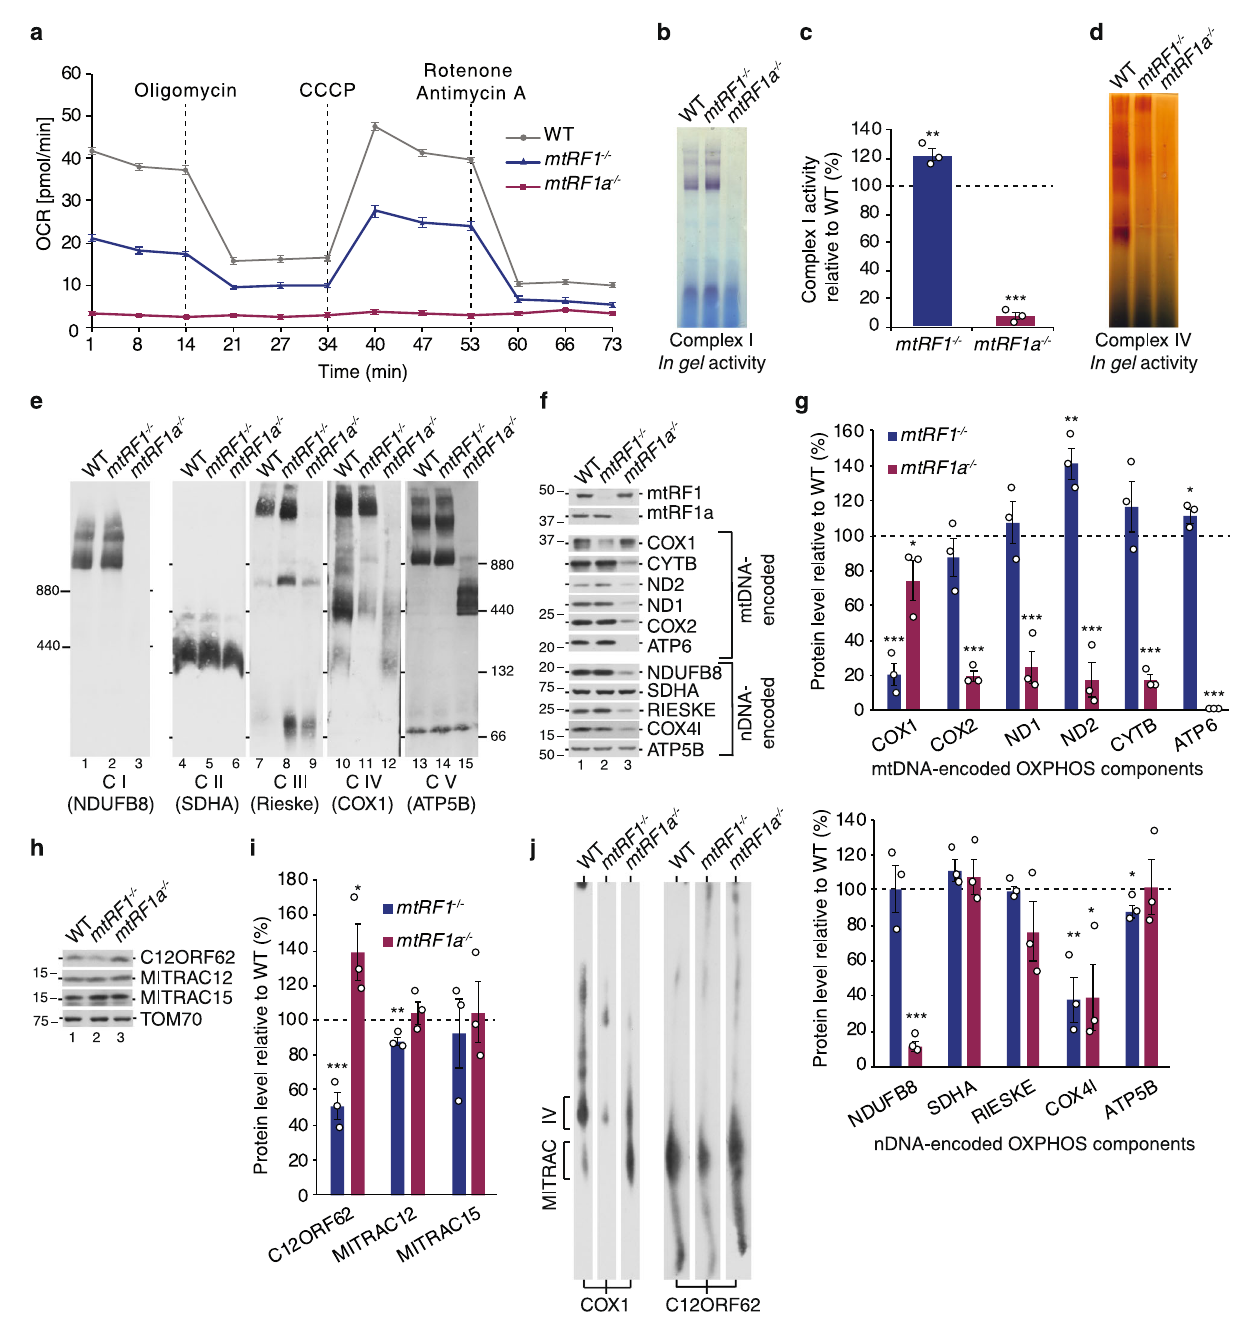
Fig. 2 | Ablation of mitochondrial release factors affects OXPHOS. a Oxygen consumptionrate(OCR)isalteredin mtRF1 − / − and mtRF1a − / − .OCRwasmeasuredfor the indicatedtime in wild-typecells (WT,gray), mtRF1 − / − (blue)and mtRF1a − / − (red). ComplexVwasblocked usingoligomycin, themembrane potentialwasuncoupled using CCCP and the activity of complex I and III was diminished by the addition of rotenone and antimycin A, respectively. b – d The activity of complex I and IV was measuredby ingel activity ( b , d ) or in a colorimetric assay( c ). c Complex I activity of WT is indicated as dashed line and individual data points are shown. Statistical analysis was performed as two-sample one-tailed Student ’ s t -test with n =3 biolo- gically independent samples shown as mean±SEM. Signi fi cance was de fi ned as ** p ≤ 0.01; *** p ≤ 0.001. e The effect of mtRF1 and mtRF1a loss on OXPHOS com- plexes. Isolated mitochondria (30 µ g) were separated by BN-PAGE (2.5 – 10% gra- dient gel: CI; 4 – 14% gradient gel: CII-CV) followed by western blotting and